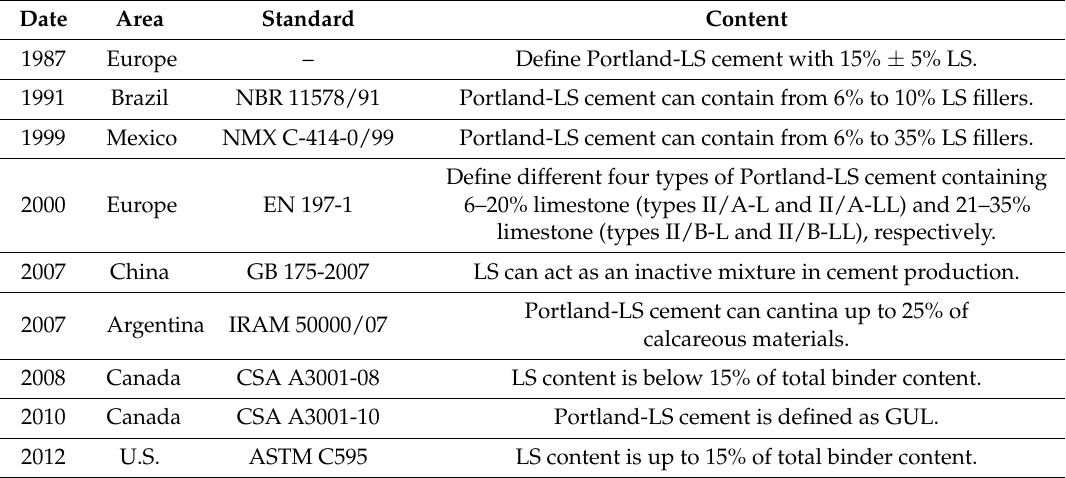
Table 1. Standards related to use of limestone in cement production in different areas